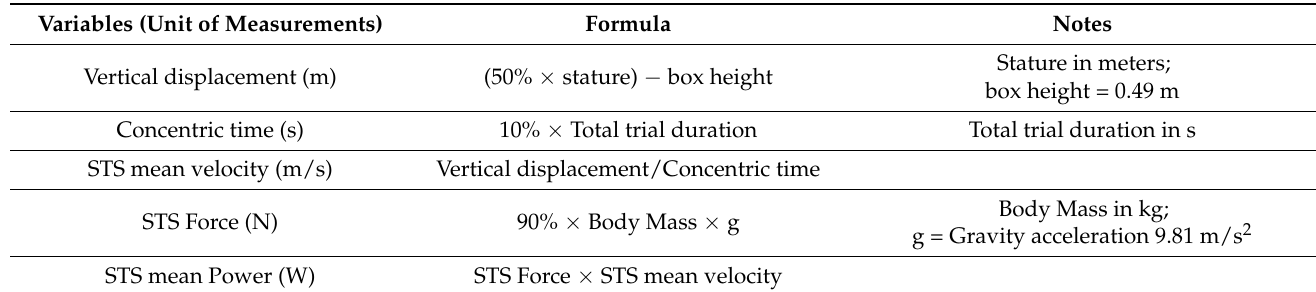
Table 2. Variables of the Alcazar’s calculation of sit-to-stand (STS) mean